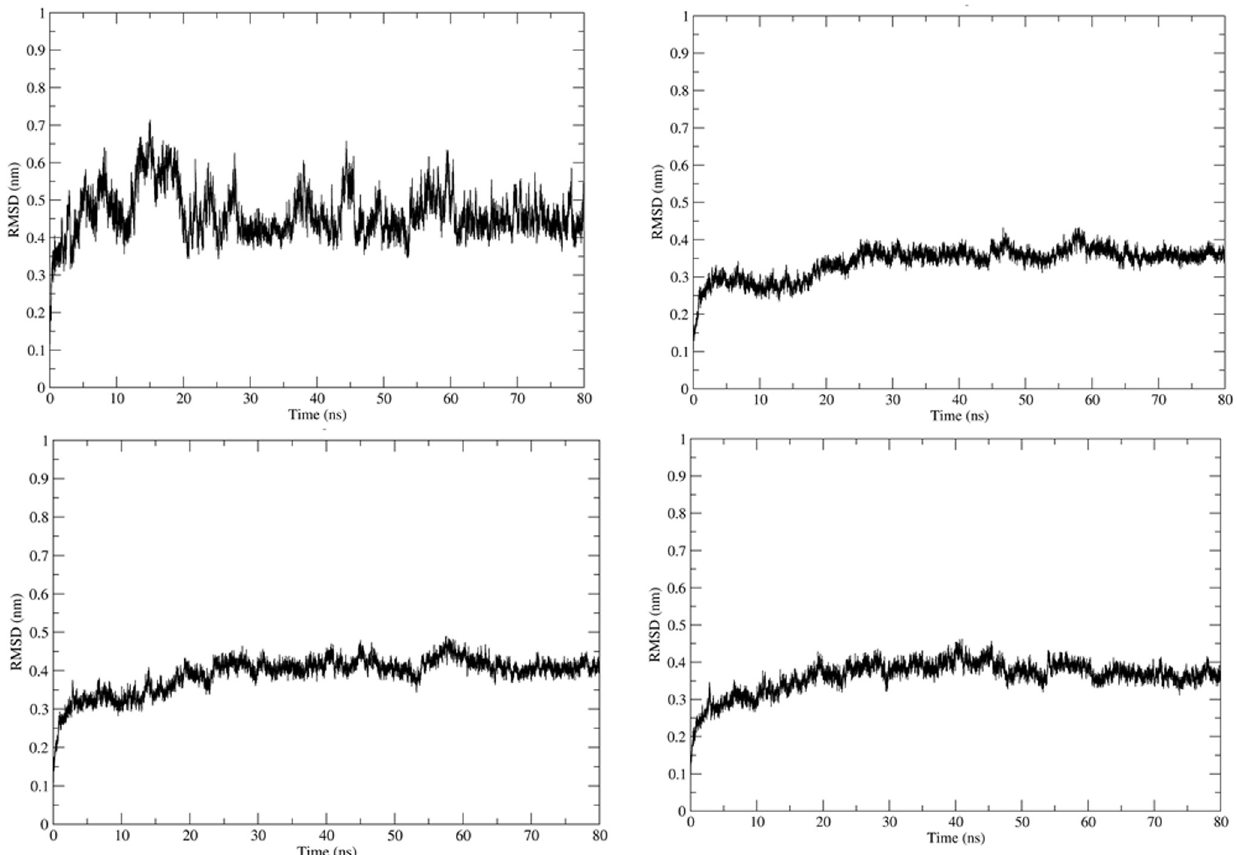
Fig 9. (a) RMSD of Peptide 7 in the complex. (b) RMSD plot of MERS-CoV RBD in the complex. (c) RMSD plot of Peptide7-MERS-CoV RBD (d) Interface of Peptide 7 and MERS-CoV in the complex.